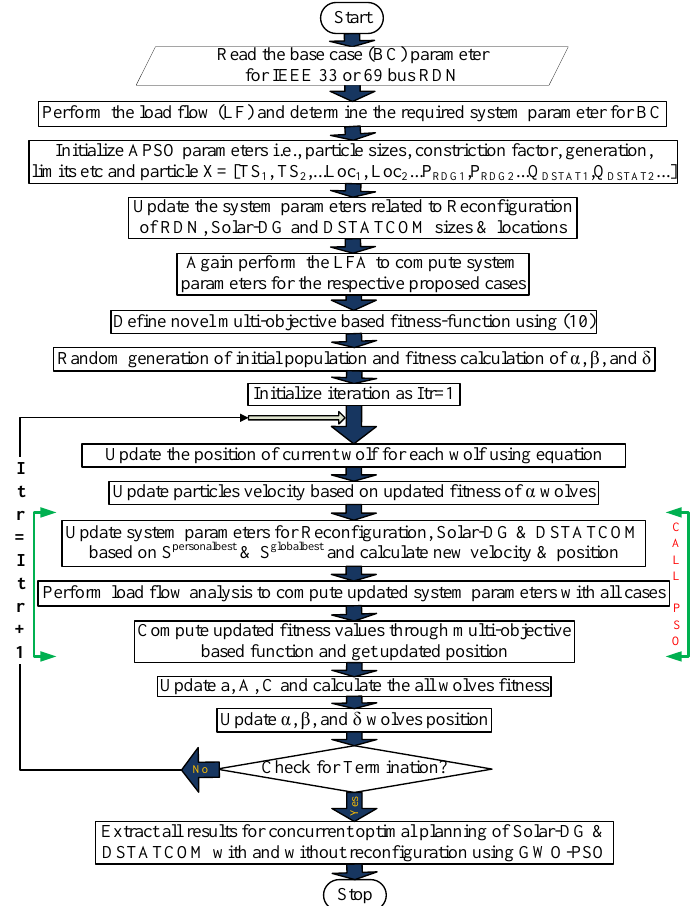
Figure 8. Flowchart for concurrent planning of multi Solar-DG and DSTATCOM in a reconfigured RDN using GWO-PSO technique.